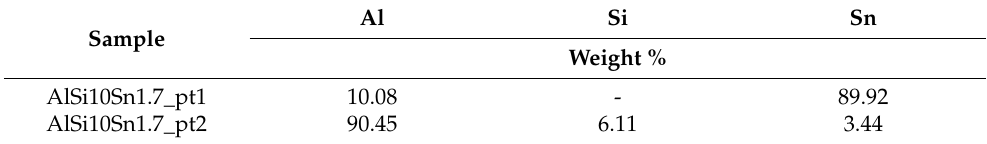
Table 7. Chemical composition of AlSi10Sn1.7 alloy in micro area from Figure 12.